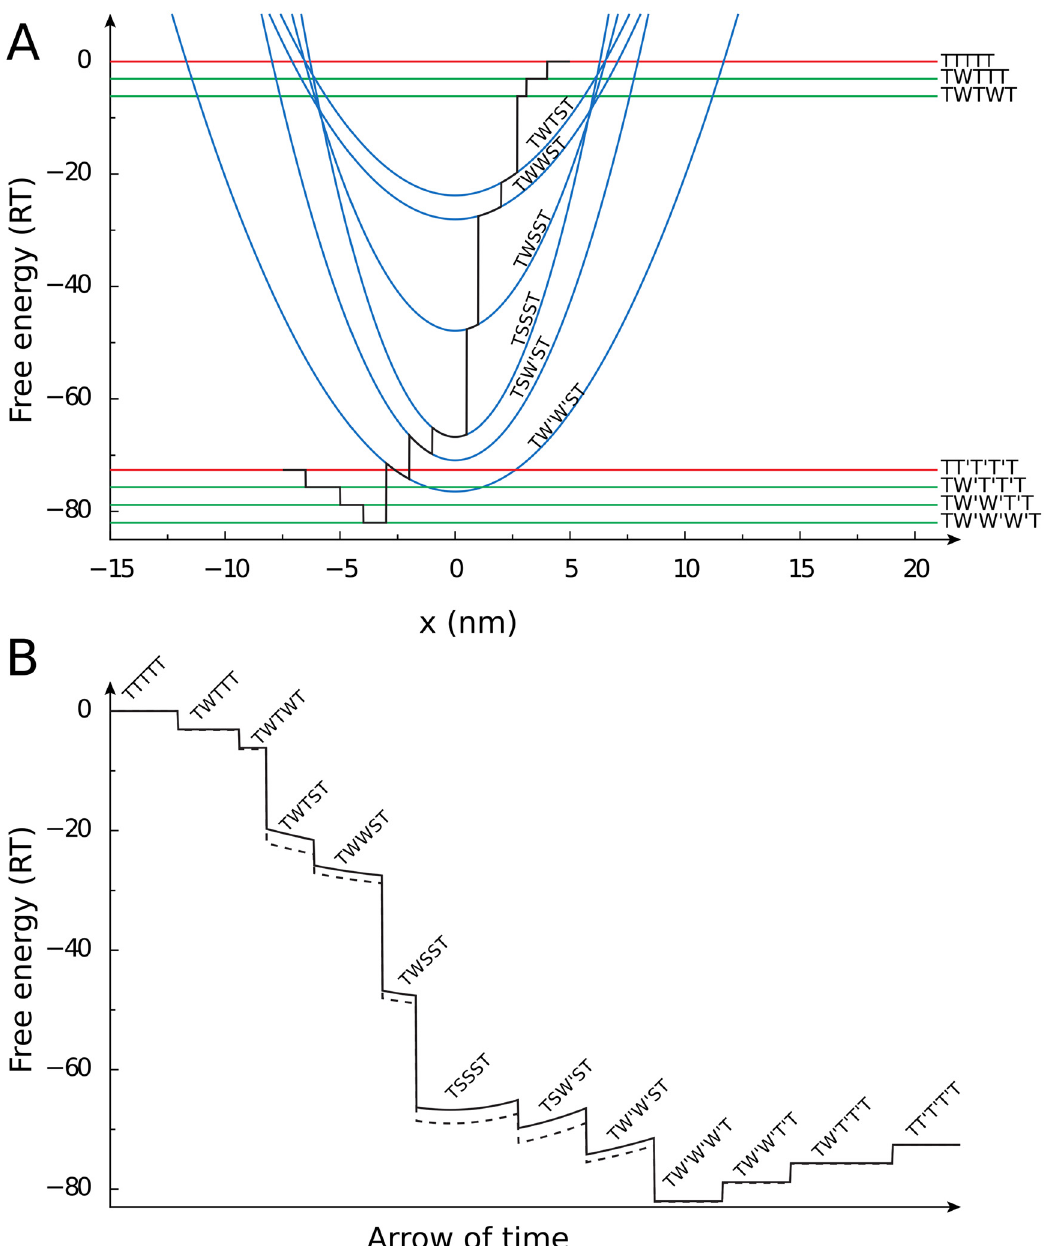
Fig 2. Scheme of free energy profiles and influence of cooperativity. (A) Scheme of one possible set of free energy profiles and transition trajectory (black solid line) from state where all five considered cross-bridges are in the unbound state (TTTTT) to state where three active cross-bridges are in unbound state with three ATP molecules hydrolyzed in reaction (TT ’ T ’ T ’ T). (B) Illustration of tropomyosin deformation influence on free energy of the cross- bridge group ensemble. The change of the free energy during reaction is shown for the simulation that takes into account the tropomyosin deformation (solid line) and for the simulation that does not take it into account (dashed line). Note that when tropomyosin deformation is considered, the change in free energy of the ensemble induced by one of the cross-bridges depend on the states of other cross-bridges in group.